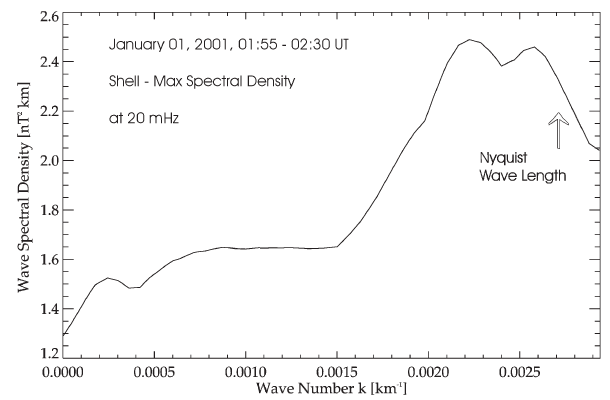
Fig. 5. Shell-max spatial spectral density distribution in logarithmic representation resulting from applying the wave telescope to mea- surements in the magnetosheath during the interval 1 January 2001, 01:55–02:30UT.